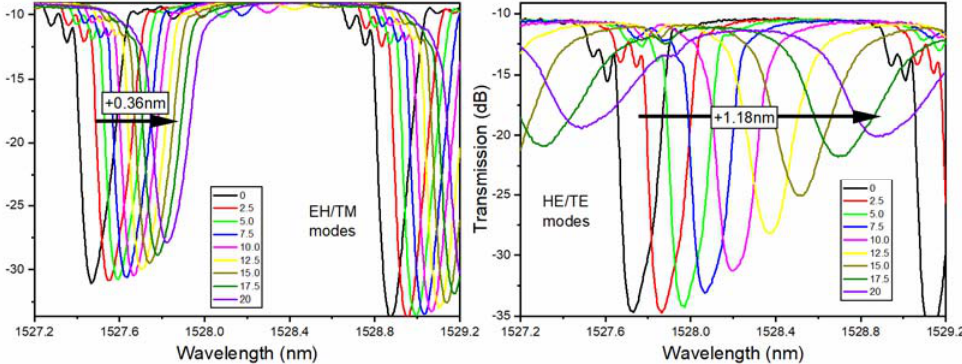
Figure 4. Evolution of P-polarized ( left ) and S-polarized ( right ) mode resonance, as a function of copper thickness in nm (as in figure legend).